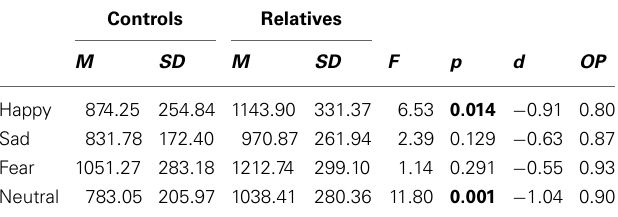
controls and relatives for each of the four emotions of the AIT.